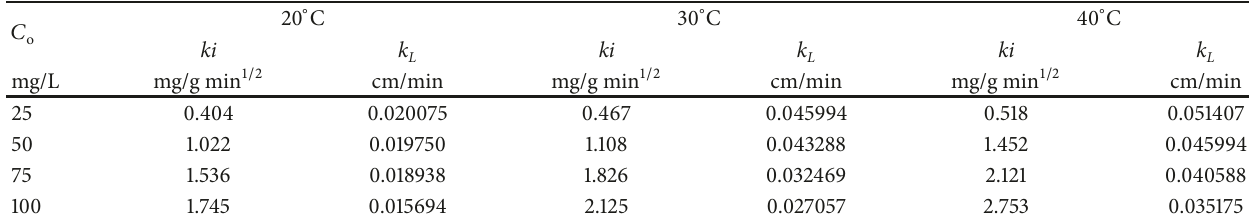
Table 5: Exchange with initial BG concentrationand temperatureon the intraparticle diffusion rate constants ( k coefficients ( 𝑘 ). L